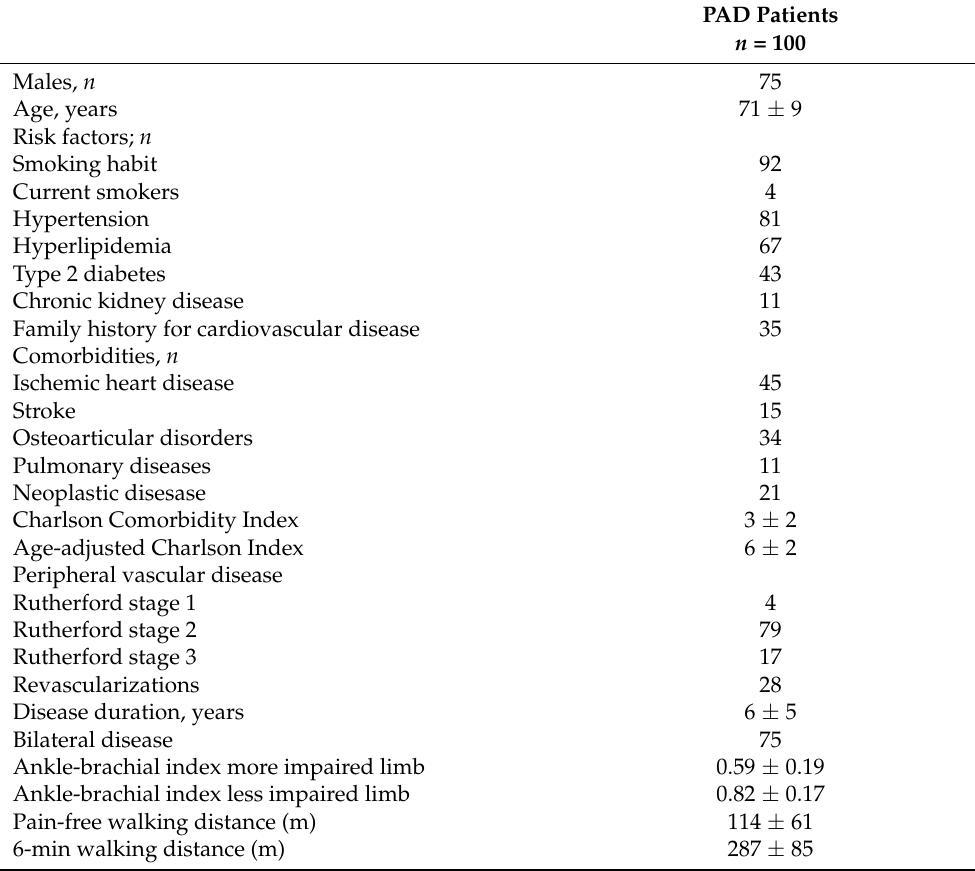
Table 2. Baseline characteristics of the patients under